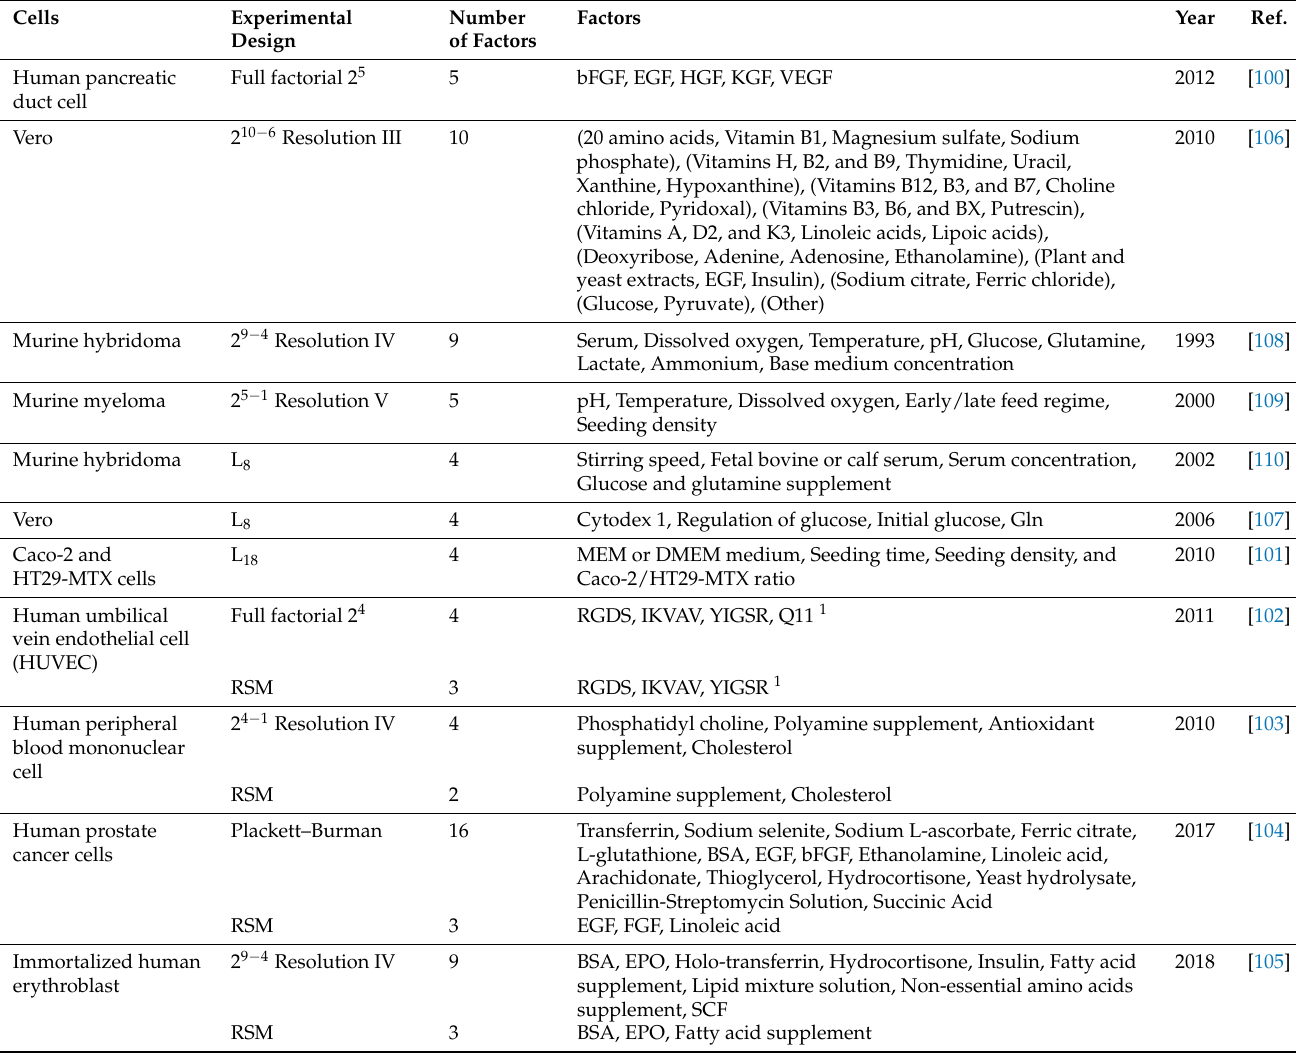
Table 6. DOE studies investigating other cell